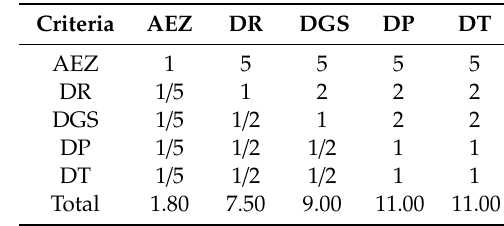
Table 17. Pairwise comparison matrix for factor criteria in Socioeconomic Analysis.